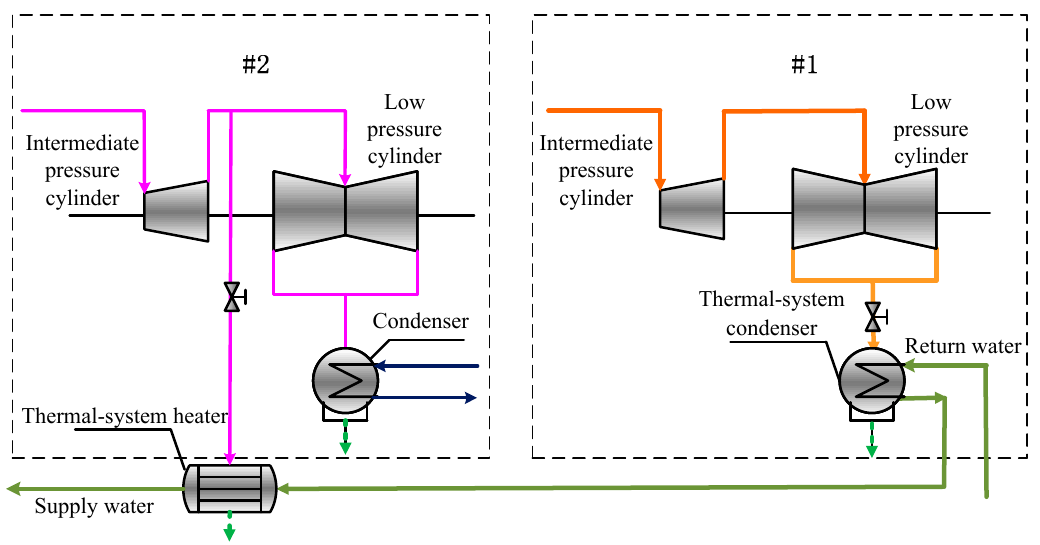
Figure 1. Schematic diagram of the 2 × 350 MW supercritical unit with high back-pressure cascade heating.